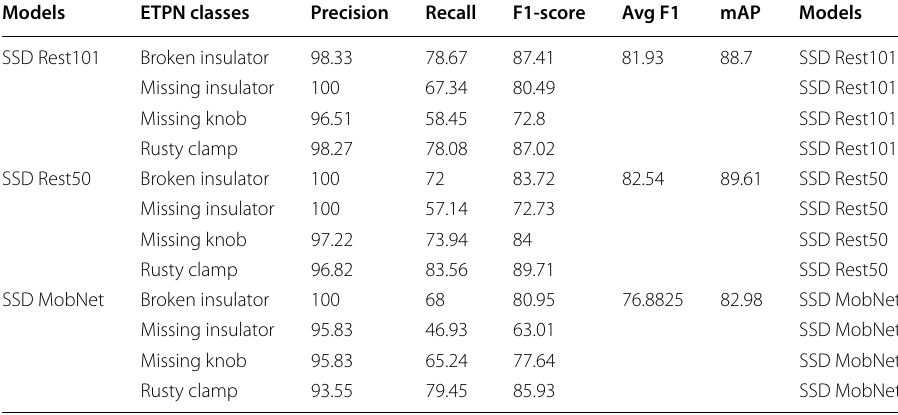
Table 5 Assessment of SSD Rest101, SSD Rest50, and SSD MobNet on the test dataset